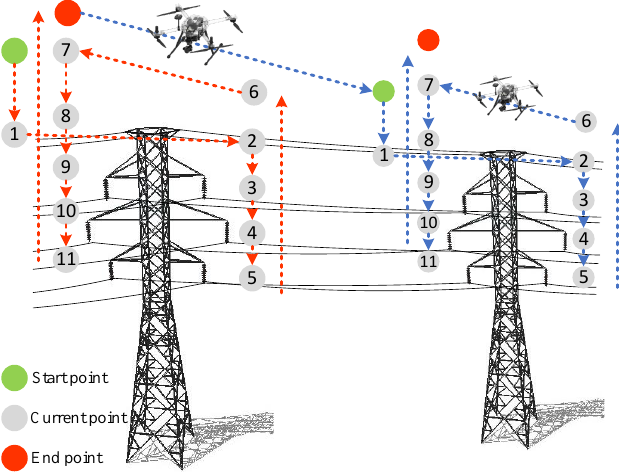
Figure 3. The process of fine